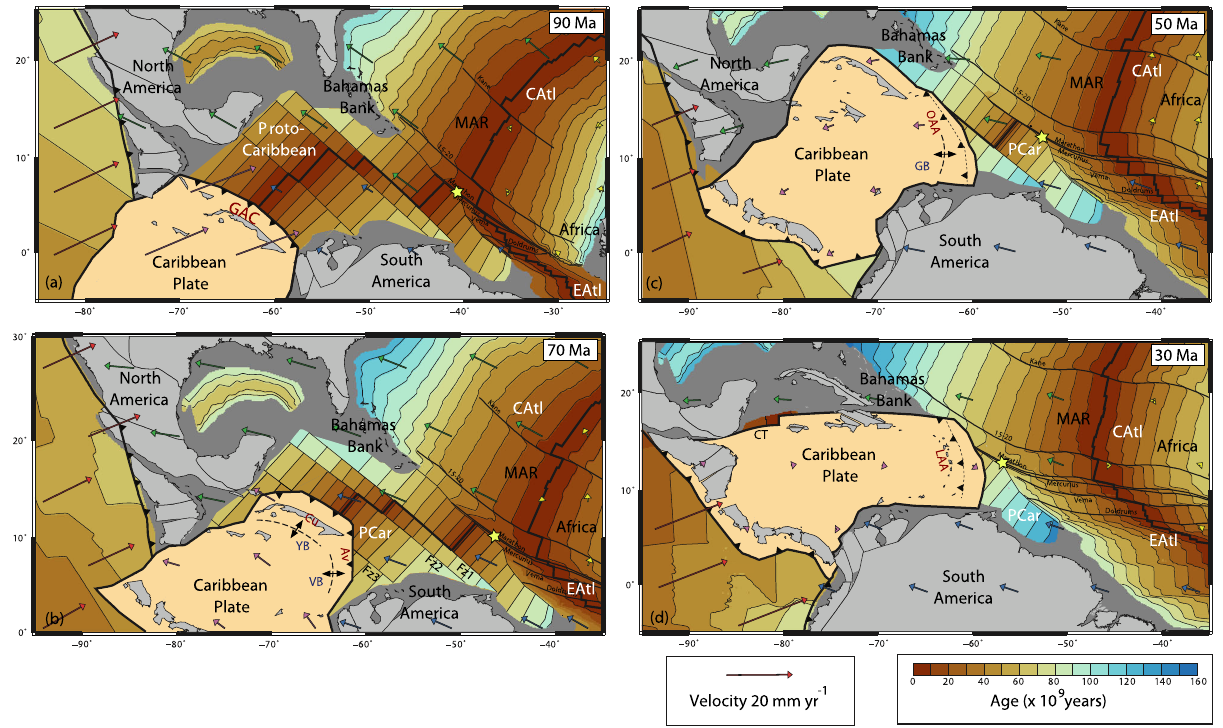
Fig. 4 Plate con fi gurations for four time periods. Reconstruction from Müller et al. 26 with modi fi cations discussed in the text. Velocities are within a mantle reference frame. Oceanic lithosphere ages are at the stated time period (colour scale from ref. 68 ). Continental lithosphere is grey, with light-grey shading showing present-day coastlines for orientation. Key Atlantic fracture zones are labelled. Yellow star indicates where the three oceanic domains (Proto-Caribbean — PCar, Central Atlantic — CAtl, Equatorial Atlantic, EAtl) meet. MAR — Mid-Atlantic Ridge ( a ) 90 Ma — an early phase of subduction along the GAC (Great Arc of the Caribbean) when the Proto-Caribbean spreading ridge was active. b 70 Ma — northern and southern parts of the GAC migrate outwards to subduct the oldest Proto-Caribbean lithosphere, accompanied by back-arc spreading in the Yucatán (YB) and Venezualan (VB) Basins behind the Cuban (Cu) and Aves/Leeward Antilles (Av) segments of the arc, respectively. Proto-Caribbean ridge stops spreading; Fz1, Fz2 and Fz3 are hypothetical fracture zones ( c ) 50 Ma — northern (Cuban) segment of GAC inactive after docking against North America, and back-arc spreading initiated in the Grenada Basin (GB), allowing the active arc to migrate east to the Outer Antillean Arc (OAA). d 30 Ma — subduction of the large-offset fracture zone(s) around the Bahamas Bank and Demerara Plateau (DP) (marked as Fz1 on panel b ) led to a rapid younging of the subducting slab, inducing a westward jump of the active arc to the current Lesser Antillean Arc (LAA), while North America-Caribbean motion is accommodated along the newly formed Cayman transform boundary